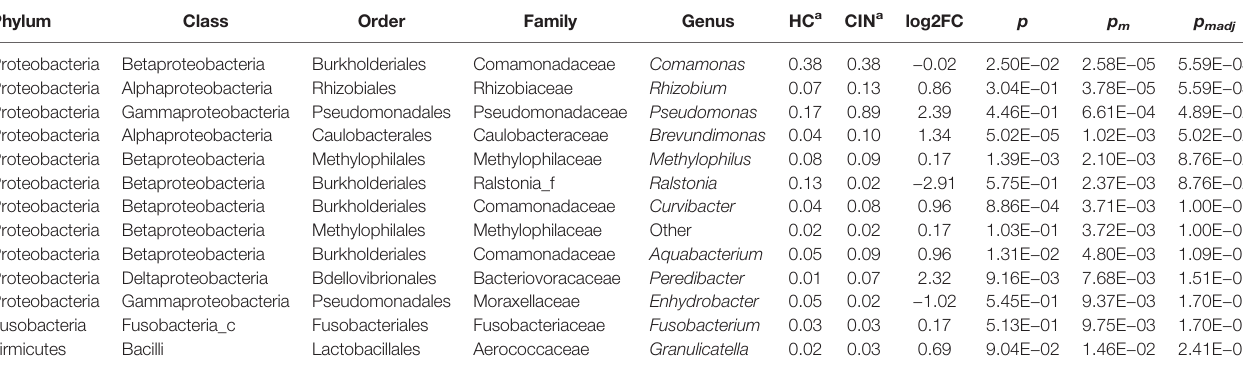
TABLE 2 | Differential abundance genus associated with CIN in cervix detected by multivariate analysis. Phylum Class